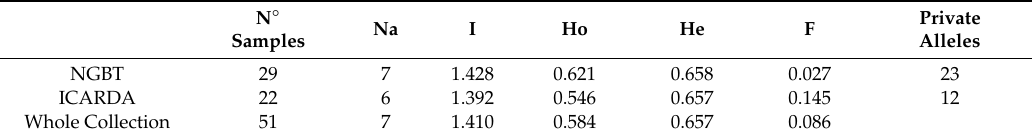
Table 2. Number of di ff erent alleles ( Na ), Shannon’s information index ( I ), Heterozygosity observed ( Ho ), Heterozygosity expected ( He ), Fixation Index ( F ), and private alleles of faba bean collection split in samples recently collected by the National Gene Bank of Tunisia (NGBT) and Agricultural Research in the Dry Areas